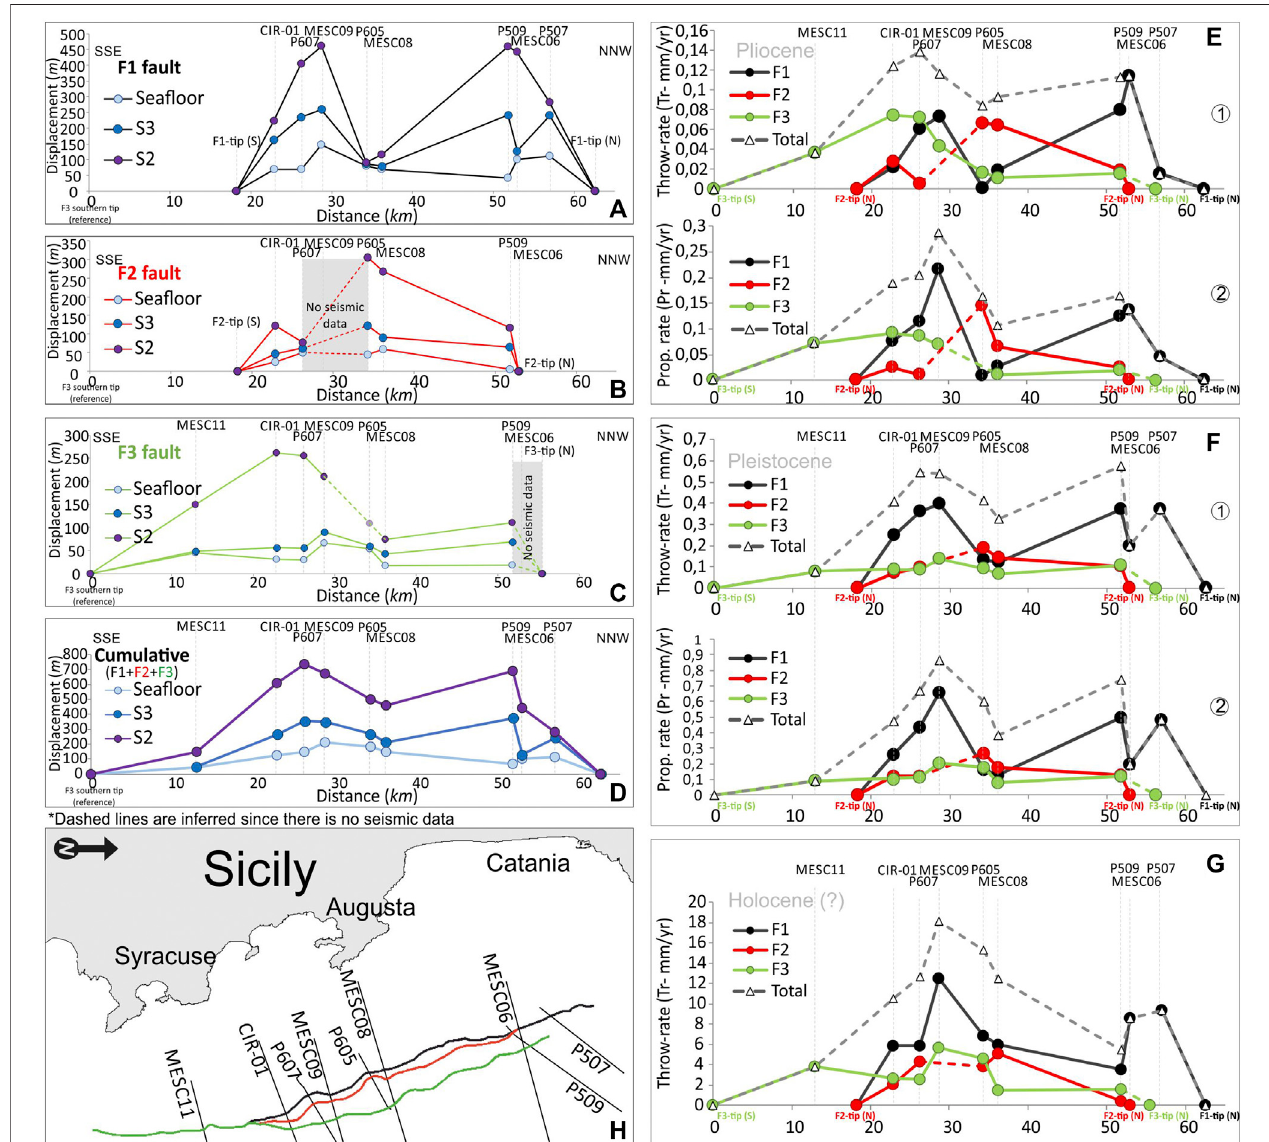
FIGURE 5 | Vertical displacement (throw) analysis performed for the F1 (A) , F2 (B) , and F3 (C) extensional structures based on the fault-displaced reference timelines(S2,S3,andsea fl oorS4).Amountofverticalandalong-dipdisplacementsforeachfaultallowstocalculatetheirthrowandpropagationrateforthePliocene (D) , Pleistocene (E) , and Holocene (F) time